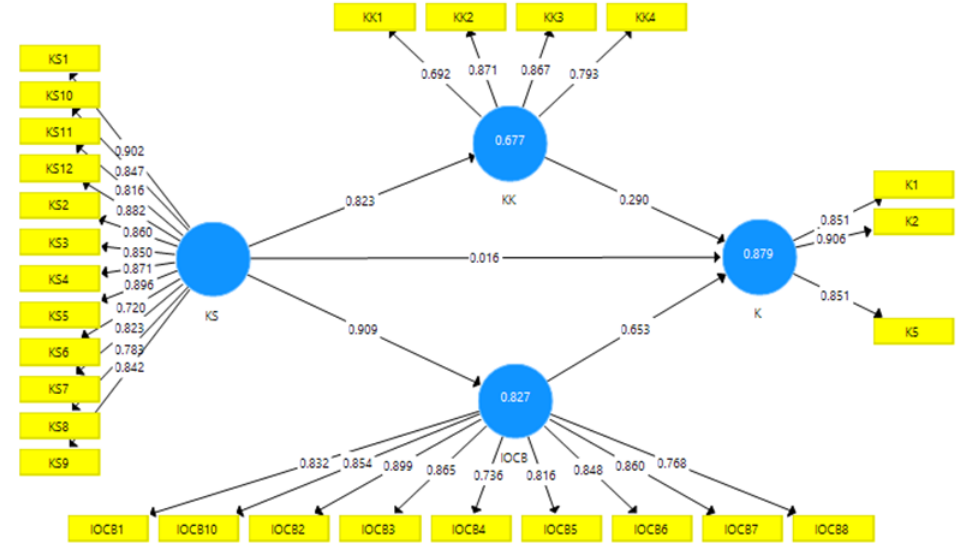
Figure 1: Results of Outer Model PLS Data